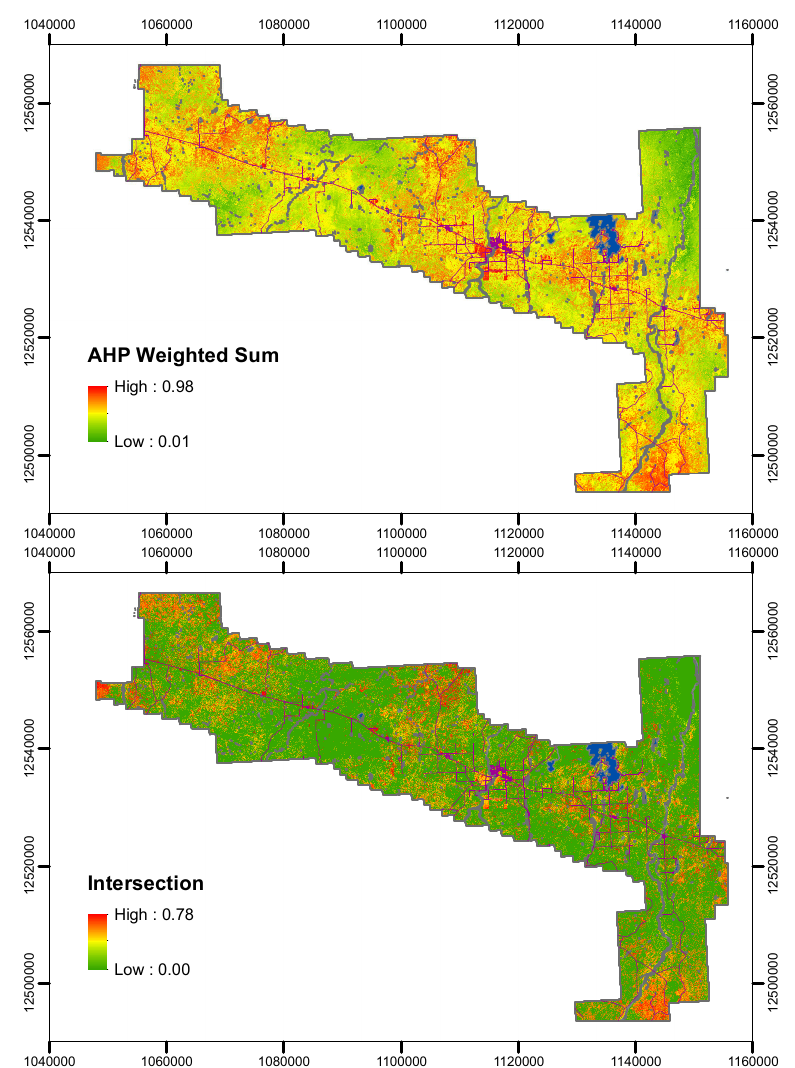
Figure 4. Areas most suitable for agriculture (as indicated in orange), with AHP weighting solution (top), and outcome with all attribute layers considered with equal weighting